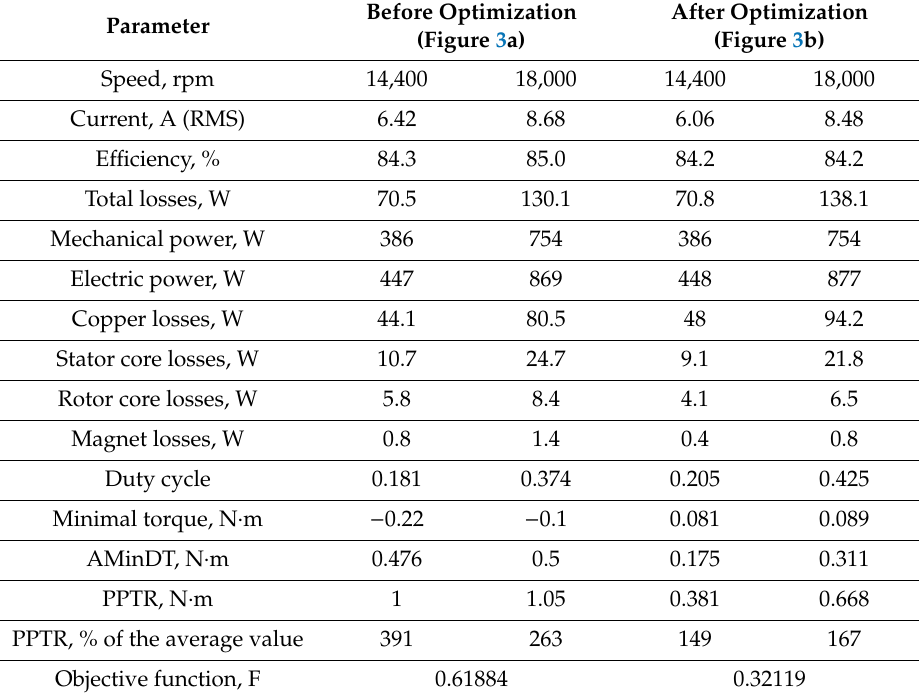
Figure 9. Change of the motor torque oscillations during the optimization. Table 4. The FRM characteristics before and after the optimization.